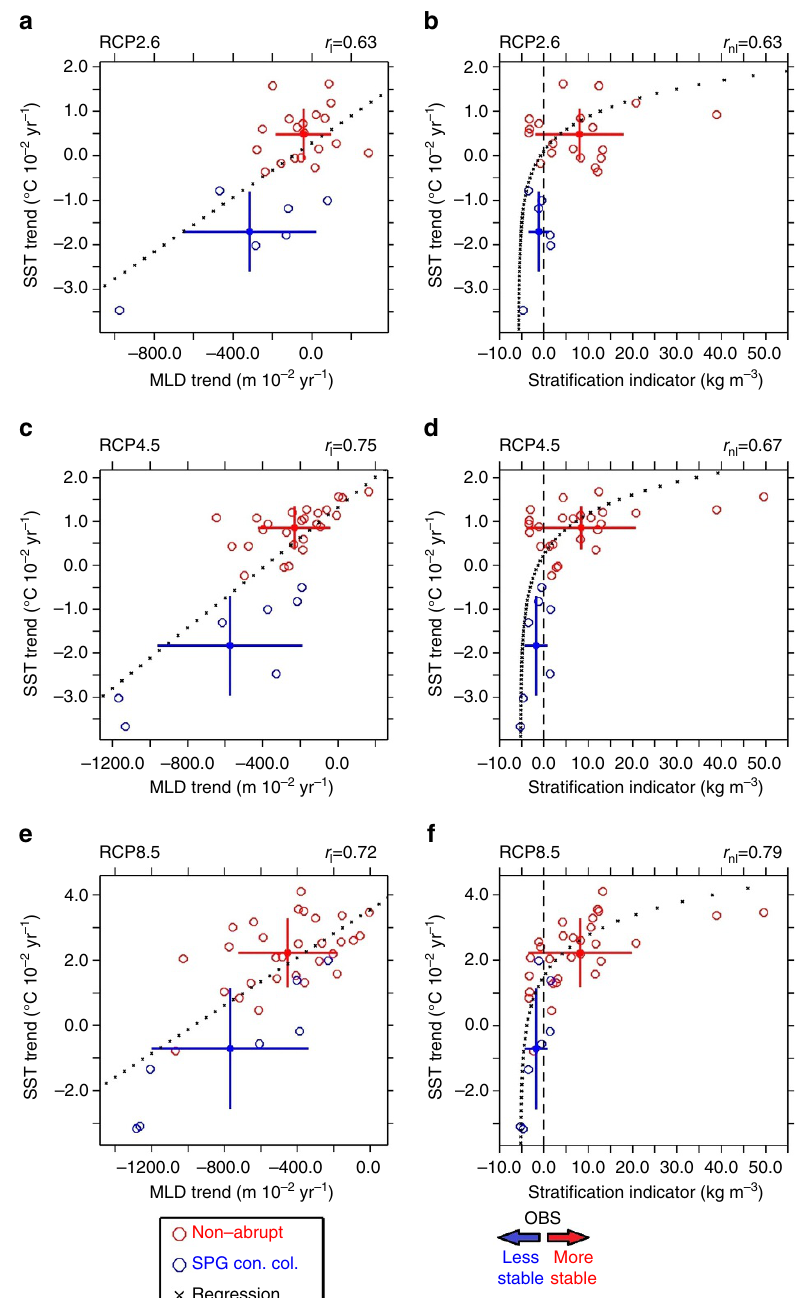
Figure 5 | The role of stratification in SPG projections. Scatterplot of simulated SST trends ( o C10 (cid:3) 2 year (cid:3) 1 ) over the SPG versus ( a , c , e ) the relevant MLD-trend (m10 (cid:3) 2 year (cid:3) 1 ) and ( b , d , f ) the present-day stratification indicator (Kgm (cid:3) 3 ). Non-abrupt models are indicated with red circles and SPG convection collapse models with blue circles, for ( a , b ) the RCP2.6, ( c , d ) the RCP4.5, ( e , f ) the RCP8.5 scenario. In a , c , e the value r l indicates the linear correlation between the SST and MLD trends, whose significance above the 95% confidence level was evaluated with a two-tailed Student’s t -test. The crosses indicate the linear best-fit of the SST trends against the MLD trend, that is,. the linear regression using the least squares method. In b , d , f the value r nl indicates the non-linear correlation between SST-trend and the stratification indicator, statistically significant at the 95% confidence level (see Methods). The crosses indicate the logarithmic best-fit of the SST trends against the stratification index, that is, the logarithmic regression using the least squares method. The dashed vertical black line centred on 0 indicates the observationally based stratification index, calculated as the average of GLORYS Reanalysis (1993–2012) data and EN3 analysis data (1950–2012). The arrows at the bottom indicate the areas in the panels for which the simulated SPG stratification is either more, or less stable than in the observational have been estimated the most reliable also by using a multi- (4.4 ± 2.4 (cid:2) C) and SSS ¼ 34.1 ± 0.6 psu (34.4 ± 0.7 psu). The parameter skill score based on SST and SSS. These different SPG convection collapse ensemble features the smallest bias in configurations, consistent with the density compensating SST and SST and SSS, that is, SST ¼ 5.9 ± 0.9 (cid:2) C (5.8 ± 0.9 (cid:2) C) and SSS biases already evidenced across the CMIP5 models 54 , further SSS ¼ 35.0 ± 0.1 psu (35.0 ± 0.2 psu), and their models would